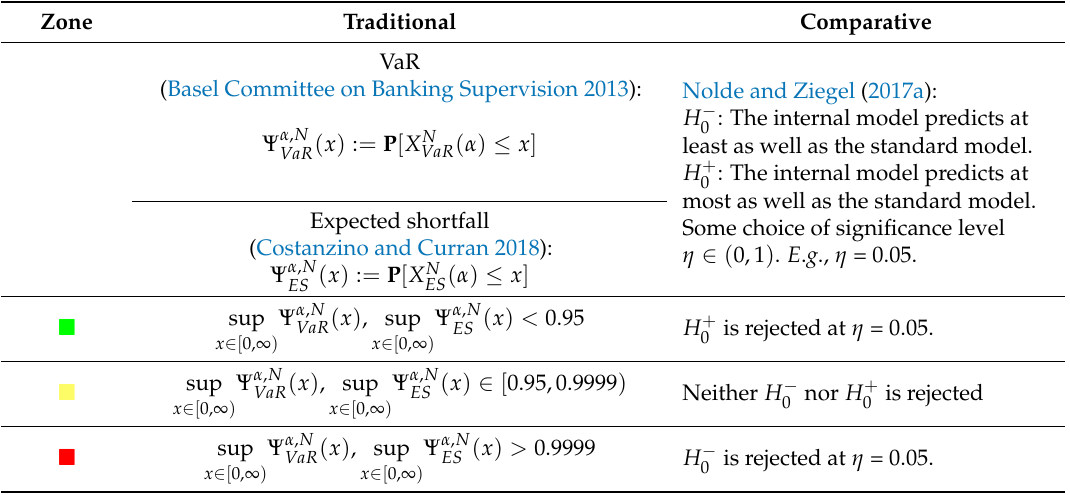
Table 2. Traffic light approaches to traditional and comparative